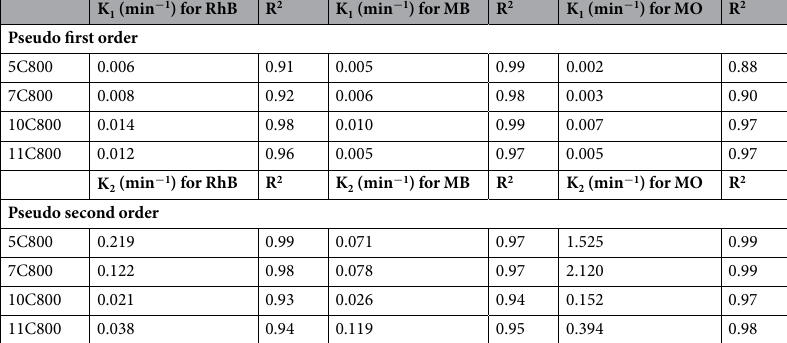
Table 5. Pseudo first and second order reactions for degradation of RhB, MB and MO.